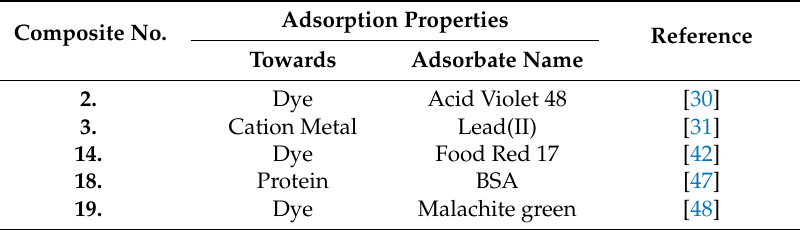
Table 3. Adsorption properties of PUR / Chit composites.